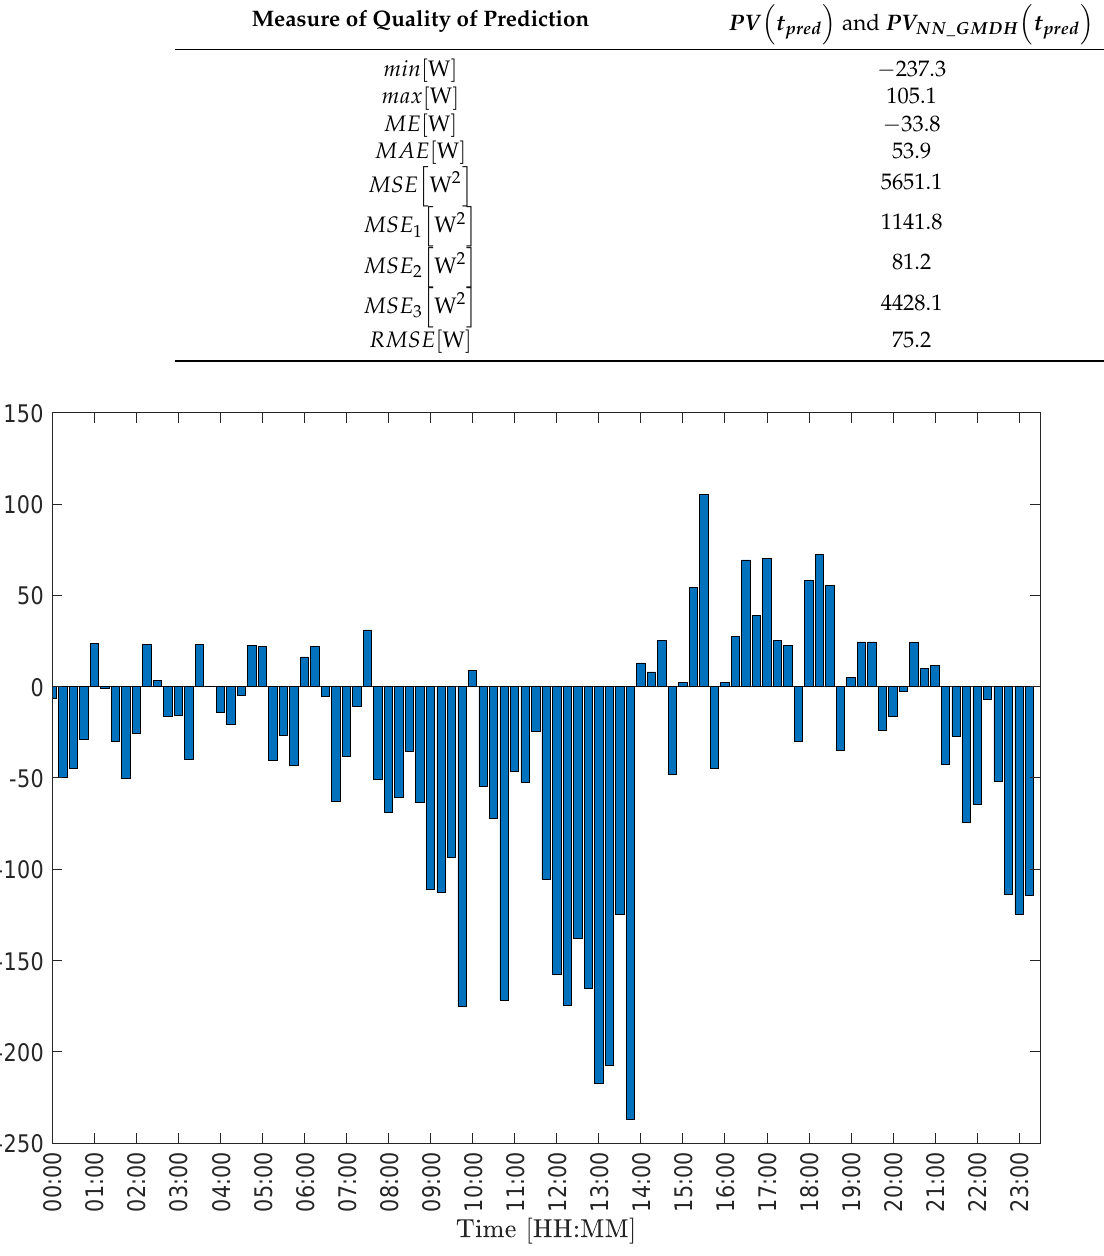
Figure 3. The obtained values of r residuals for predicting the power generated by RES in the form of photovoltaic